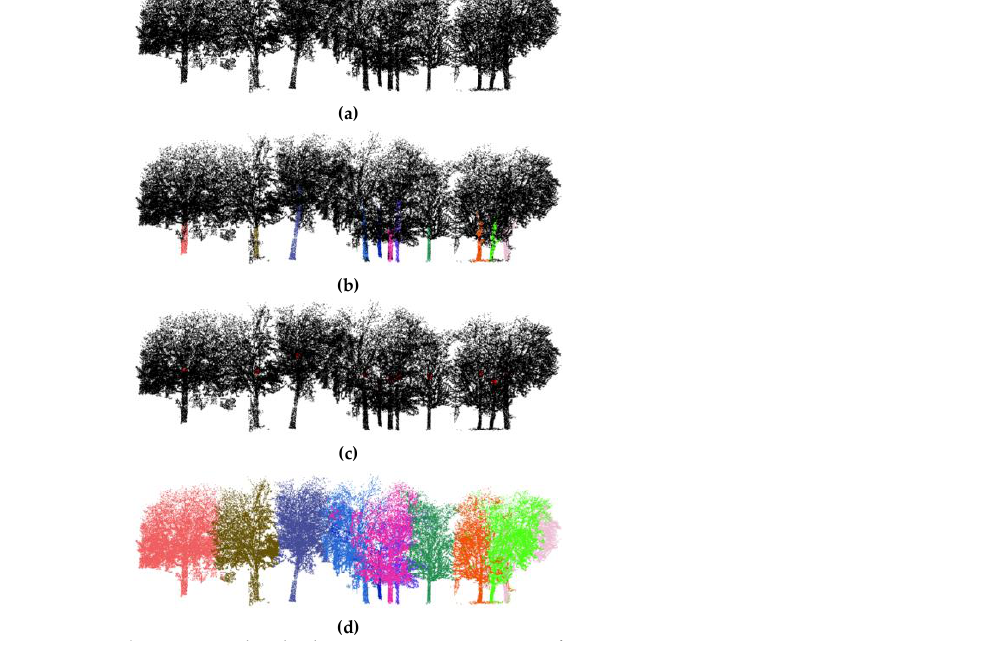
Figure 11. Individual tree extraction process of Scene 4. ( a ) The PCD of trees. ( b ) Trunk extraction result. ( c ) Crown center extraction result. ( d ) Individual tree extraction result.